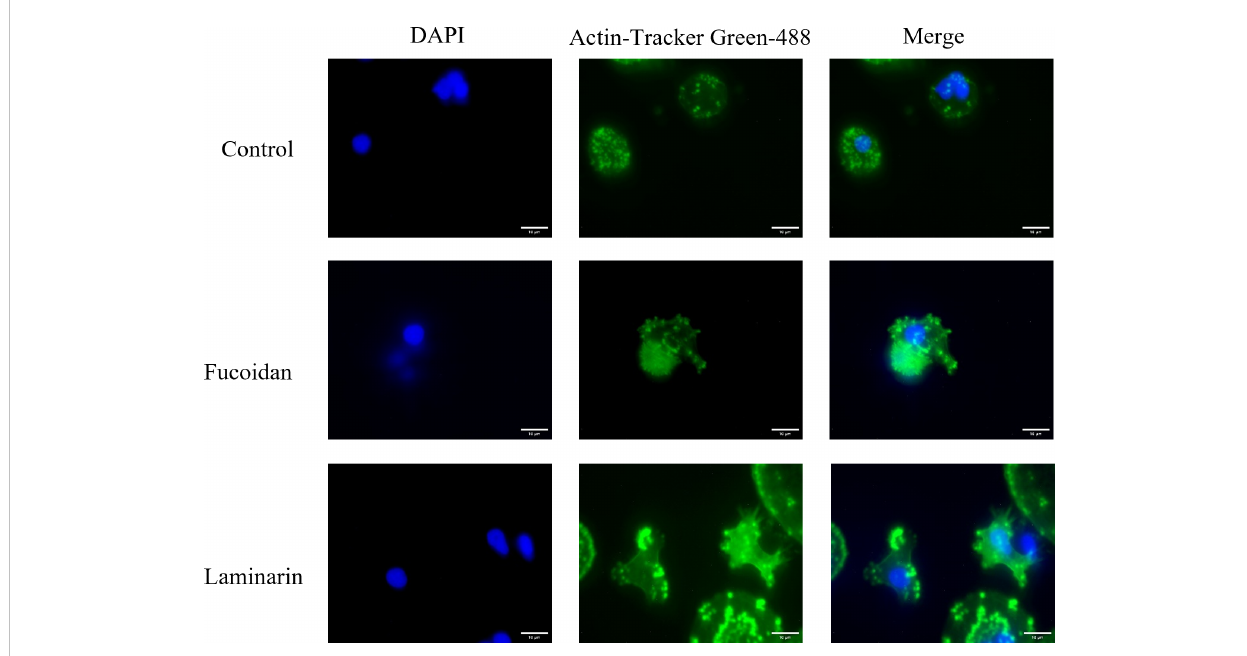
FIGURE 2 Fucoidan and laminarin induce skeletal remodeling of macrophages. The nuclei and skeleton of macrophages were stained with DAPI and Actin- Tracker Green-488, respectively, and then recorded under a fl uorescent microscope. Image J was used to merge two fl uorescent photographs with the same fi eld of view to show the overall cell morphology. Scale bars = 10 m